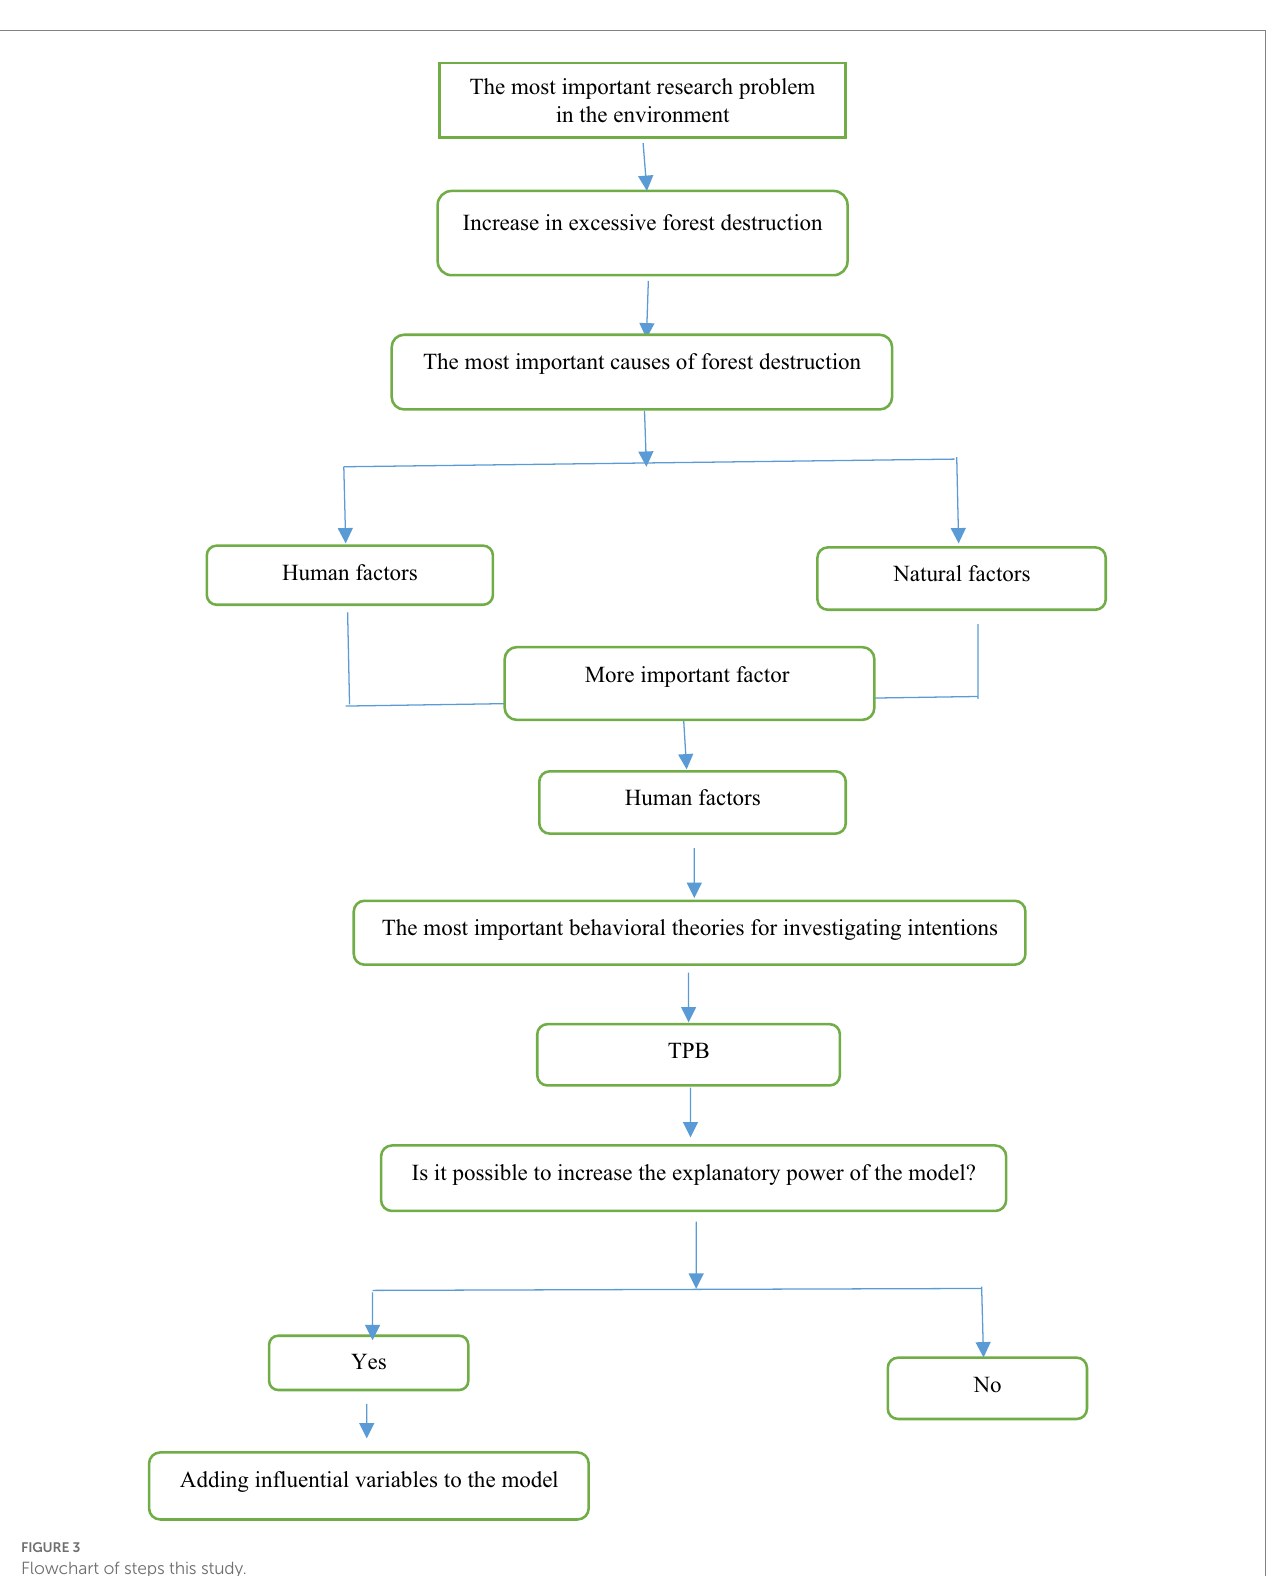
FIGURE 3 Flowchart of steps this